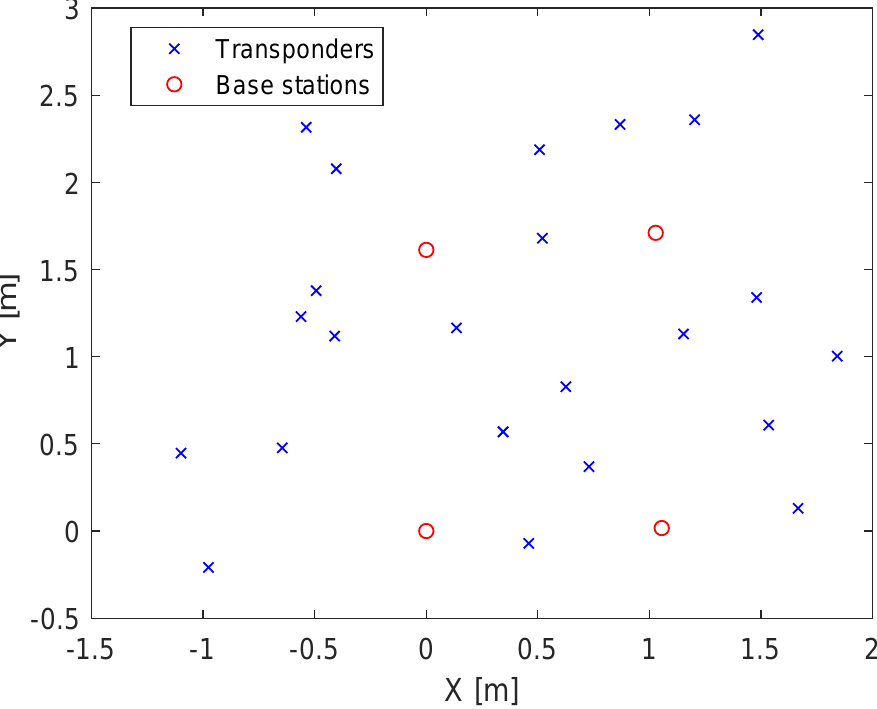
Figure 4. Constellation of the DecaWave UWB systems. The red circles are the real base stations locations, and the crosses are the tag